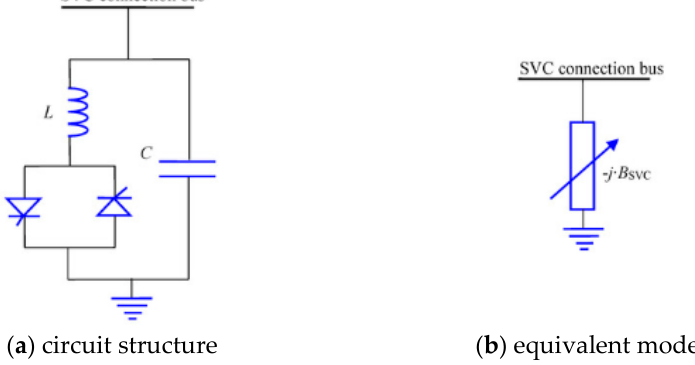
Figure 2. A Distribution-Static Var Compensator (D-SVC).